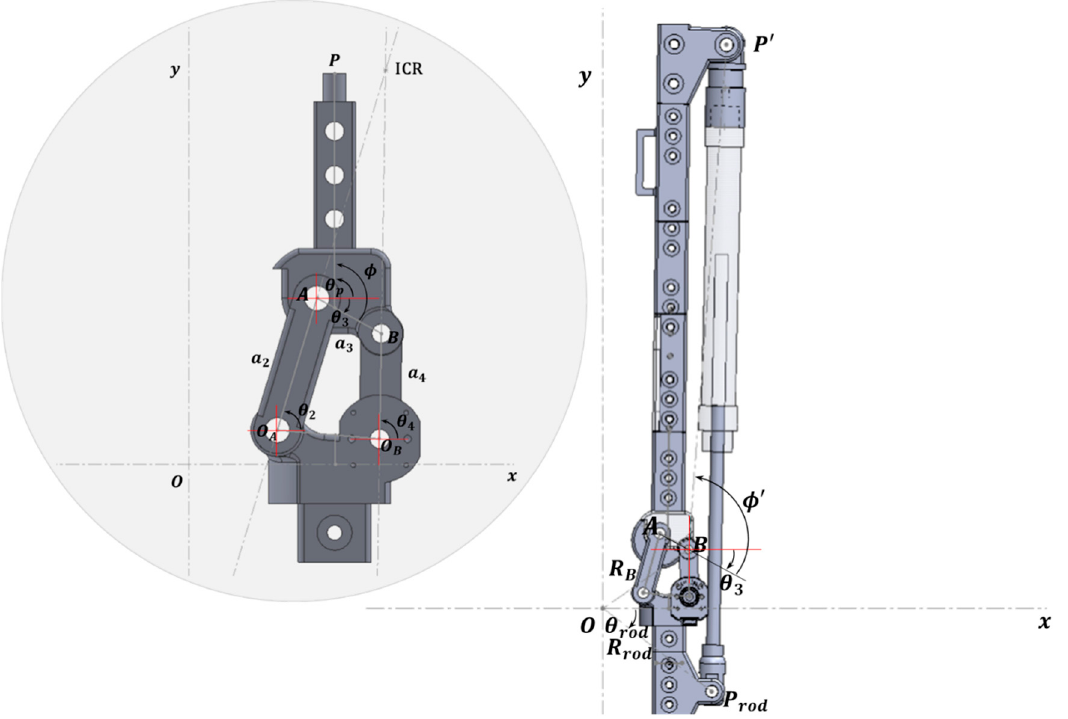
(cid:48) and P rod to calculate actuator